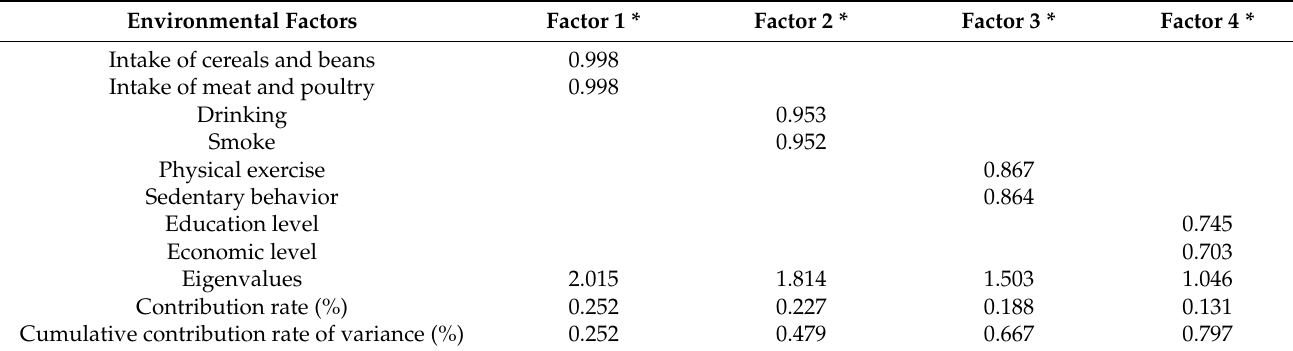
Table 2. Factor analysis of T2D-risk-related environmental factors.